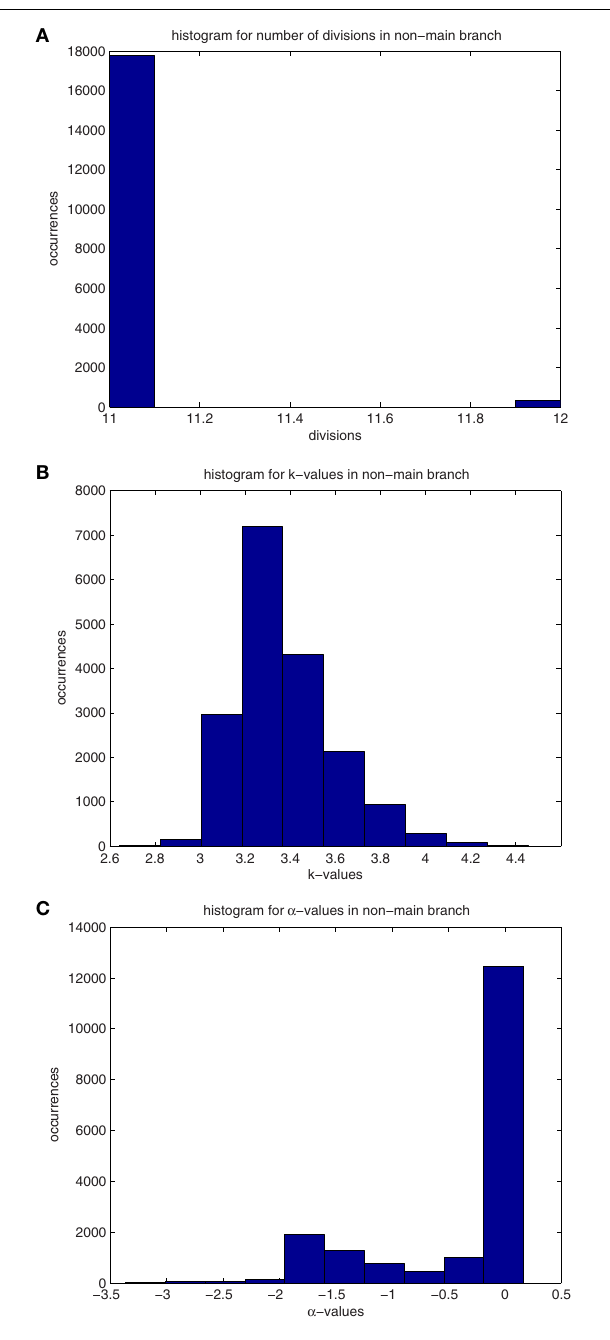
FIGUREA1 | (A) Histograms for the median values of division number, d , of cells that are not descendant from the main branch.Values are recorded from 74 primary tumors.The properties in these histograms are similar to those of “normal” cells, ones that are following the differentiation pathway. (B) Histograms for the median values of differentiation coefficient, k , of cells that are not descendant from the main branch.Values are recorded from 74 primary tumors.The properties in these histograms are similar to those of “normal” cells, ones that are following the differentiation pathway. (C) Histograms for the median values of proliferation potential, α , of cells that are not descendant from the main branch.Values are recorded from 74 primary tumors.The properties in these histograms are similar to those of “normal” cells, ones that are following the differentiation pathway.